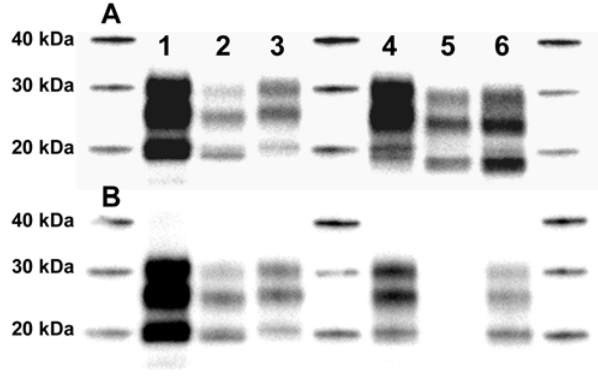
Figure 2. PrP res Profiles in iCJD Patients. PrP res (frontal cortex) was revealed in WB by antibodies Sha31 (A) and 12B2 (B). Lane 1, MM UK dura mater patient; lane 2, VV French dura mater patient; lane 3, MM GH French patient; lane 4, French MV GH patient; lane 5, MV UK GH patient; lane 6, VV UK GH patient.